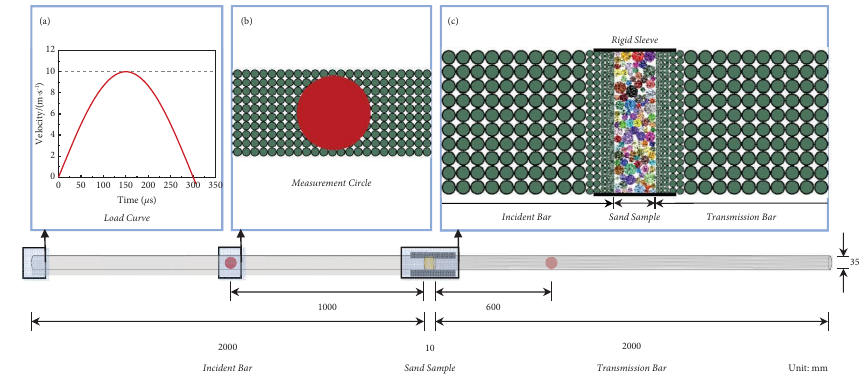
Figure 1: Numerical model of the SHPB